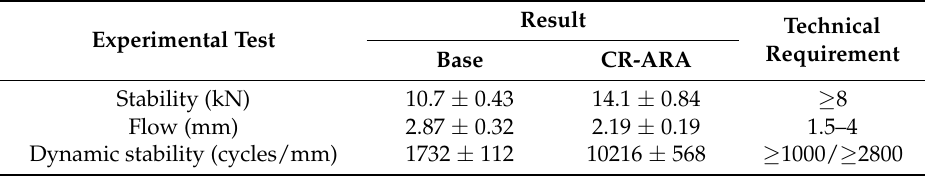
Table 8. Marshall stability and wheel tracking results of mix obtained from mixing